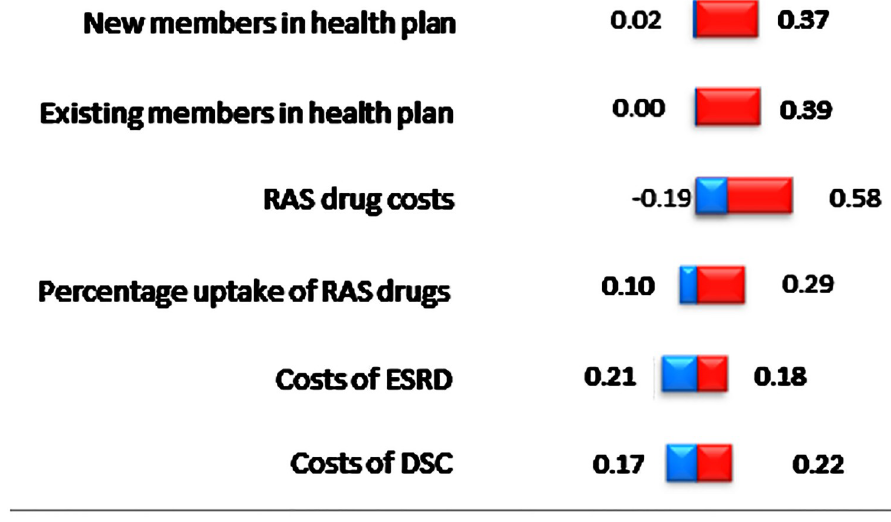
Fig 3. Tornado diagram of incremental per-member per-month costs (MYR) after increasing uptake of renin- angiotensin system inhibitor drugs.